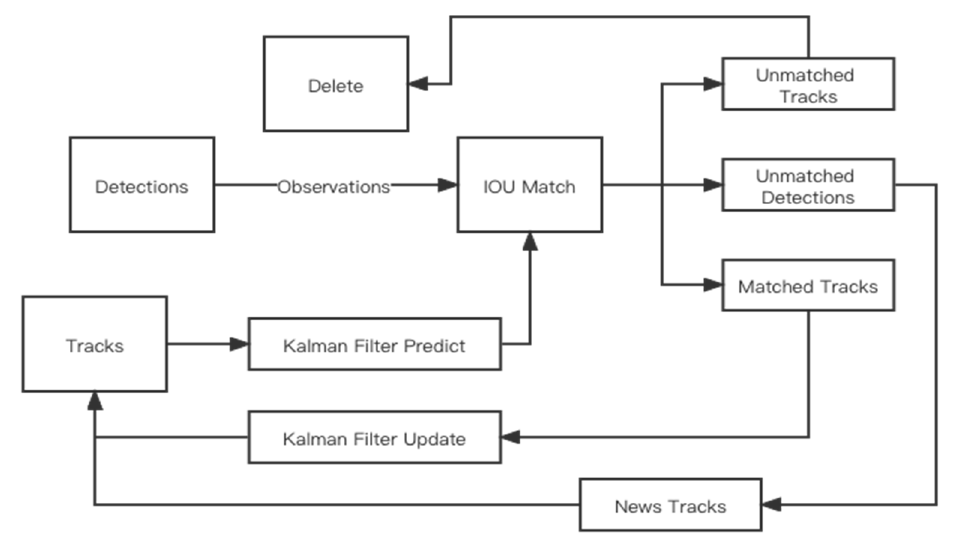
Figure 6. Improved DeepSORT